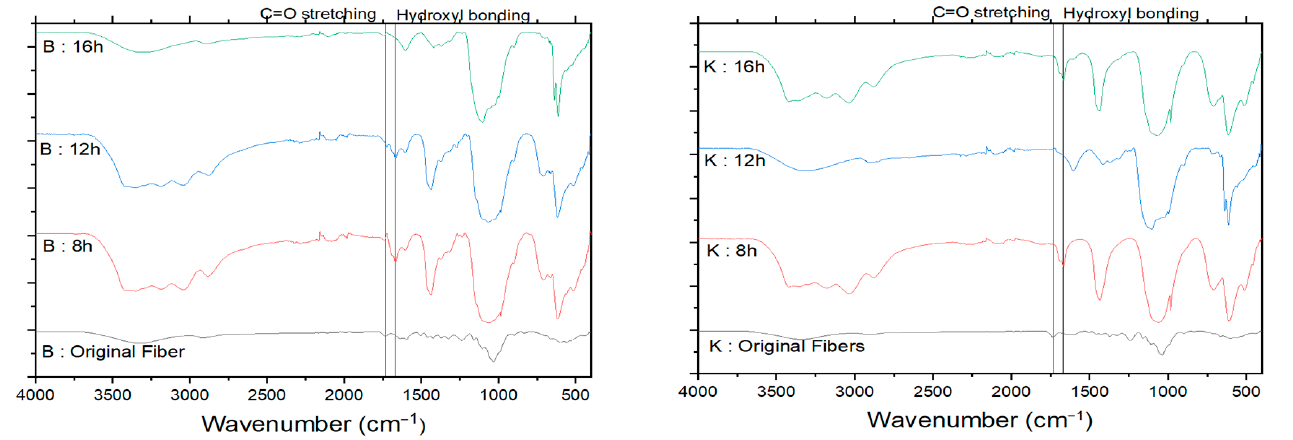
Figure 4. FTIR spectra of balsa ( left ) and kapok ( right ) fibers and the resultant CNCs.